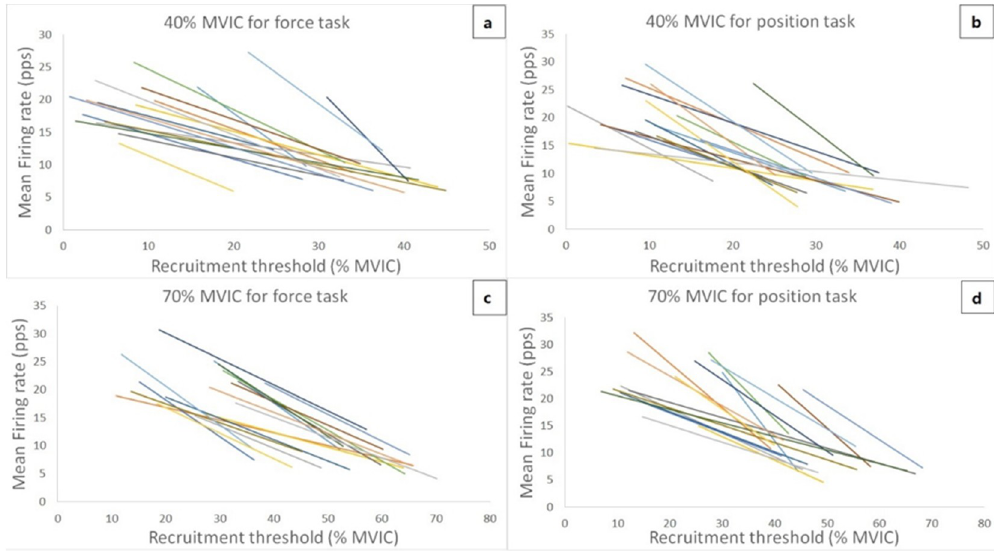
Figure 3. The theoretical regression lines obtained from the recruitment threshold (RT) versus the mean firing rate (MFR) relationship for 17 subjects during the force task and position task at 40% and 70% maximal voluntary isometric contraction (MVIC).